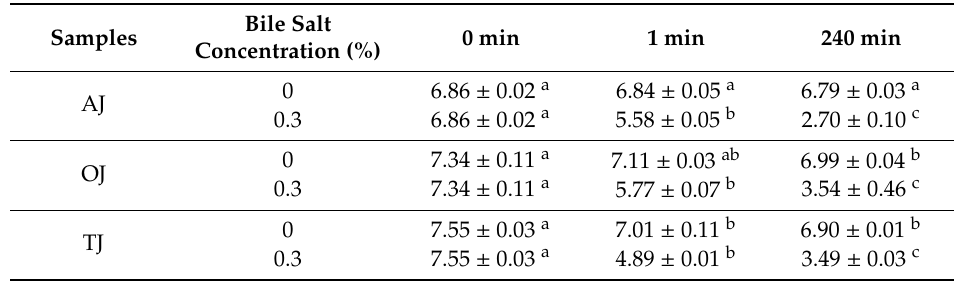
Table 2. The change of viability of probiotics in fruit and vegetable juice samples in the digestion of simulated small intestinal juice (with and without bile salt) (pH =